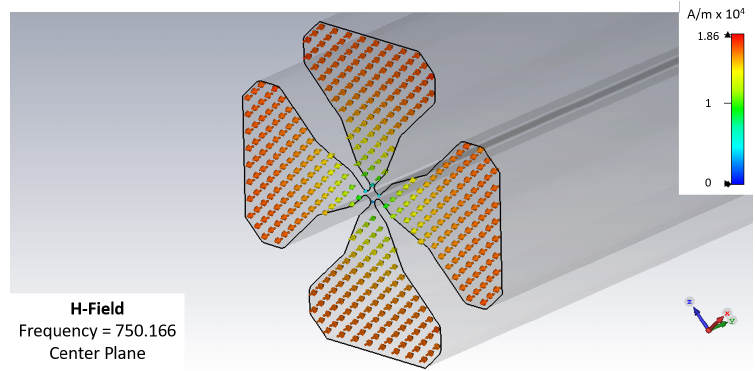
Figure 12. Quadrupolar magnetic fields in a transversal cut of the RFQ